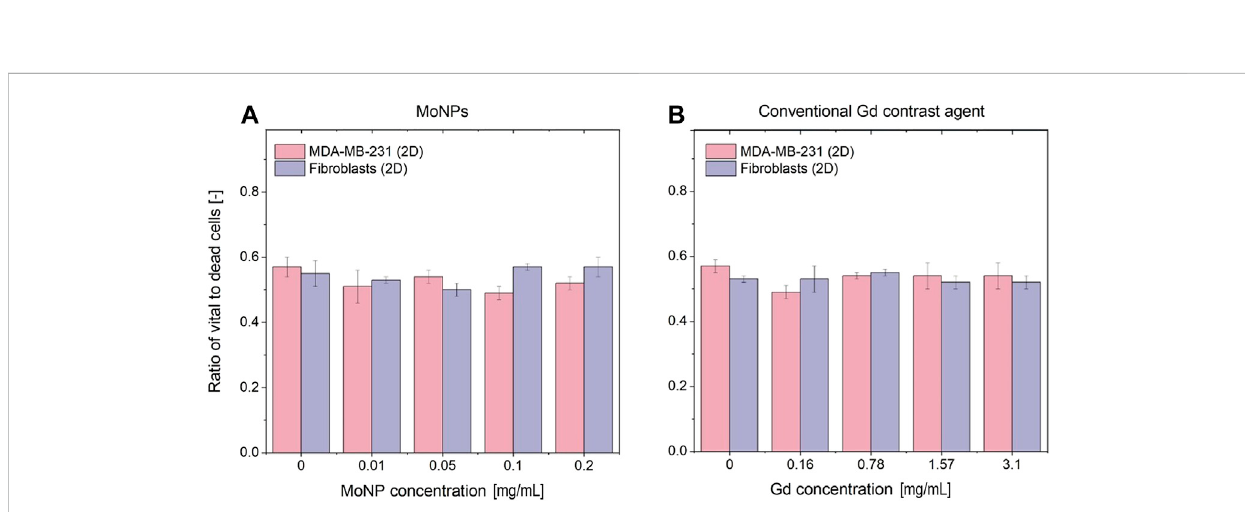
FIGURE 8 Cytotoxicity of the investigated conventional and nanoparticle-based contrast agents measured by Ki-67 immunohistochemistry staining and cell counting (A) for MoNP treatment and (B) Gd treatments in the 3D tissue-engineered breast cancer model after 48 h incubation. The data points are represented as the mean ± standard deviation of triplicate